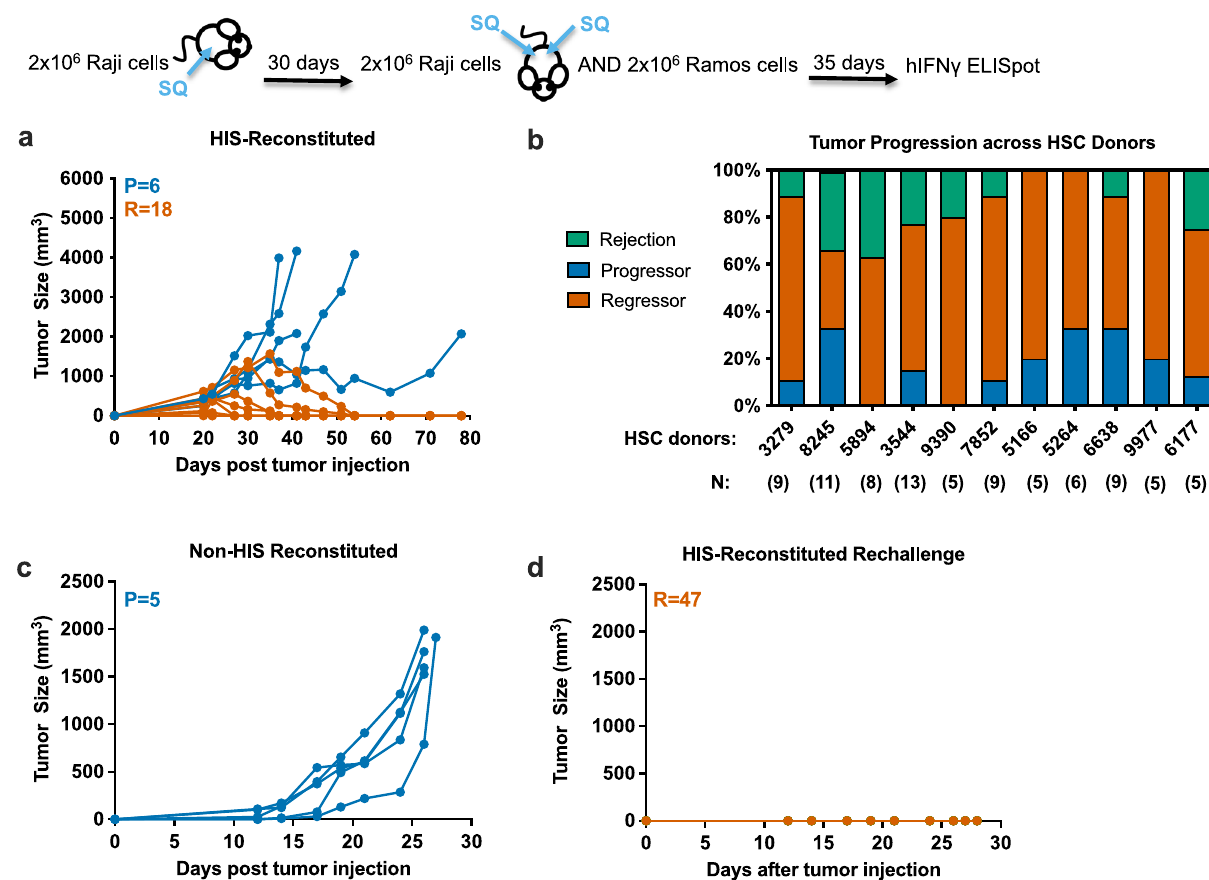
Fig. 1 HIS mice show strong growth control and memory response against the Raji human tumor cell line. a Newborn pups were given a sublethal irradiation dose 4 – 24 h prior to an intrahepatic injection of human fetal liver (FL) derived CD34 + cells. Human immune system (HIS) reconstitution was con fi rmed 10 – 12 weeks post-engraftment by checking human CD45 levels by fl ow cytometry. Mice were implanted subcutaneously into the right fl ank with Raji tumor cells, and tumor growth outcome was recorded ( n = 24). Progressor (P; blue) is de fi ned as tumor growth only. Regressor (R; orange) is de fi ned as having two tumor volume values smaller than the preceding peak value. Rejection is de fi ned as having two tumor volume values where the second value is zero. Regressor group: R; combined regressor and rejection groups: R. b The 80 mice were reconstituted with hematopoietic stem cells from 11 human donors. c Non-HIS-reconstituted mice were implanted with Raji tumor ( n = 5). d Mice that rejected Raji tumor during the primary challenge were rechallenged with Raji cells ( n =